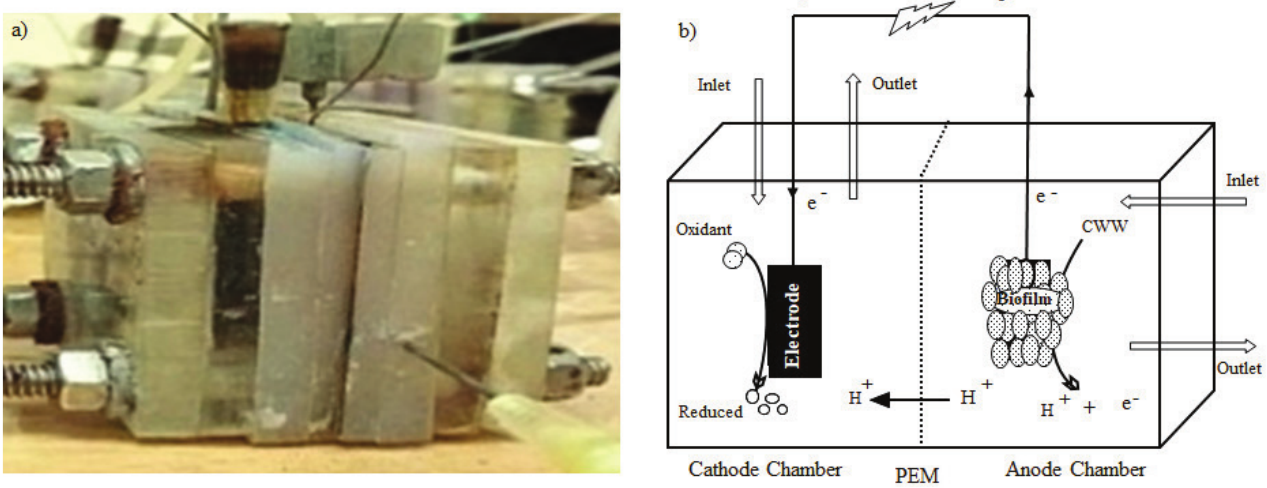
Fig. 1 – Experimental setup of the CW-MFC in laboratory (a), and the schematic diagram of the CW-MFC